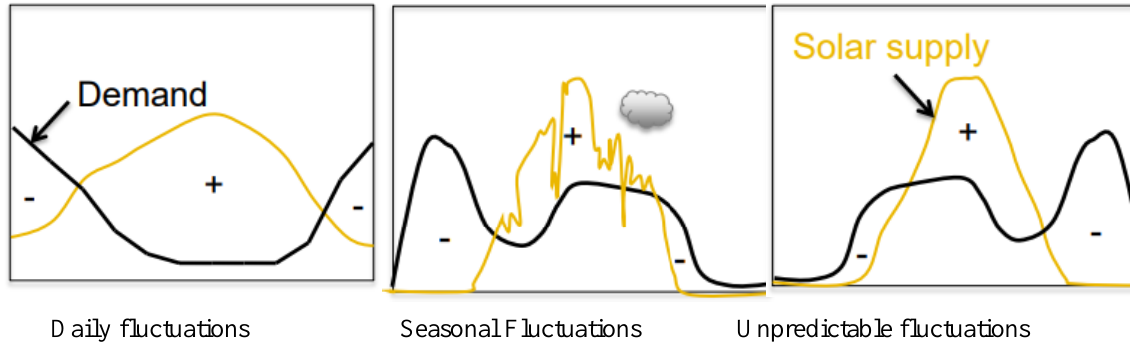
Figure 1. Solar energy: fluctuations in different timescales